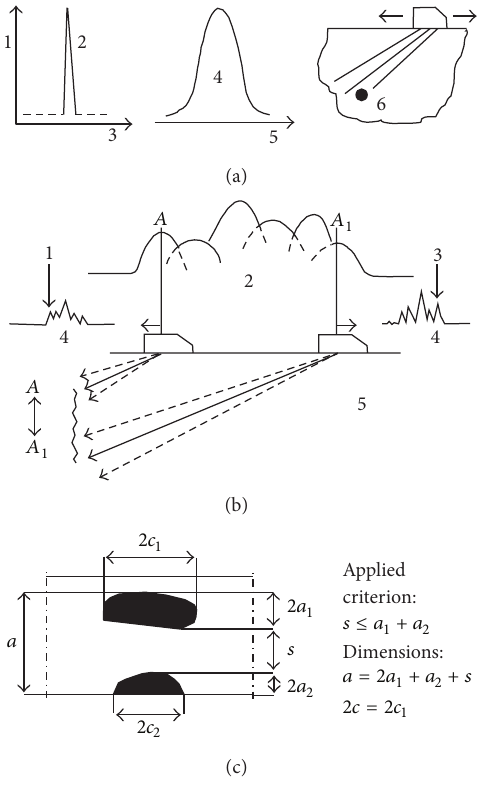
Figure 2: The course of the explosive welding process: 𝑉 𝑝 is the flyer plate velocity, 𝐶 is the collision point, 𝑉 𝐶 is the collision point velocity, 𝑉 𝑑 is the detonation velocity, 𝛽 is the collision angle, and 𝜆 is the joint wavelength.